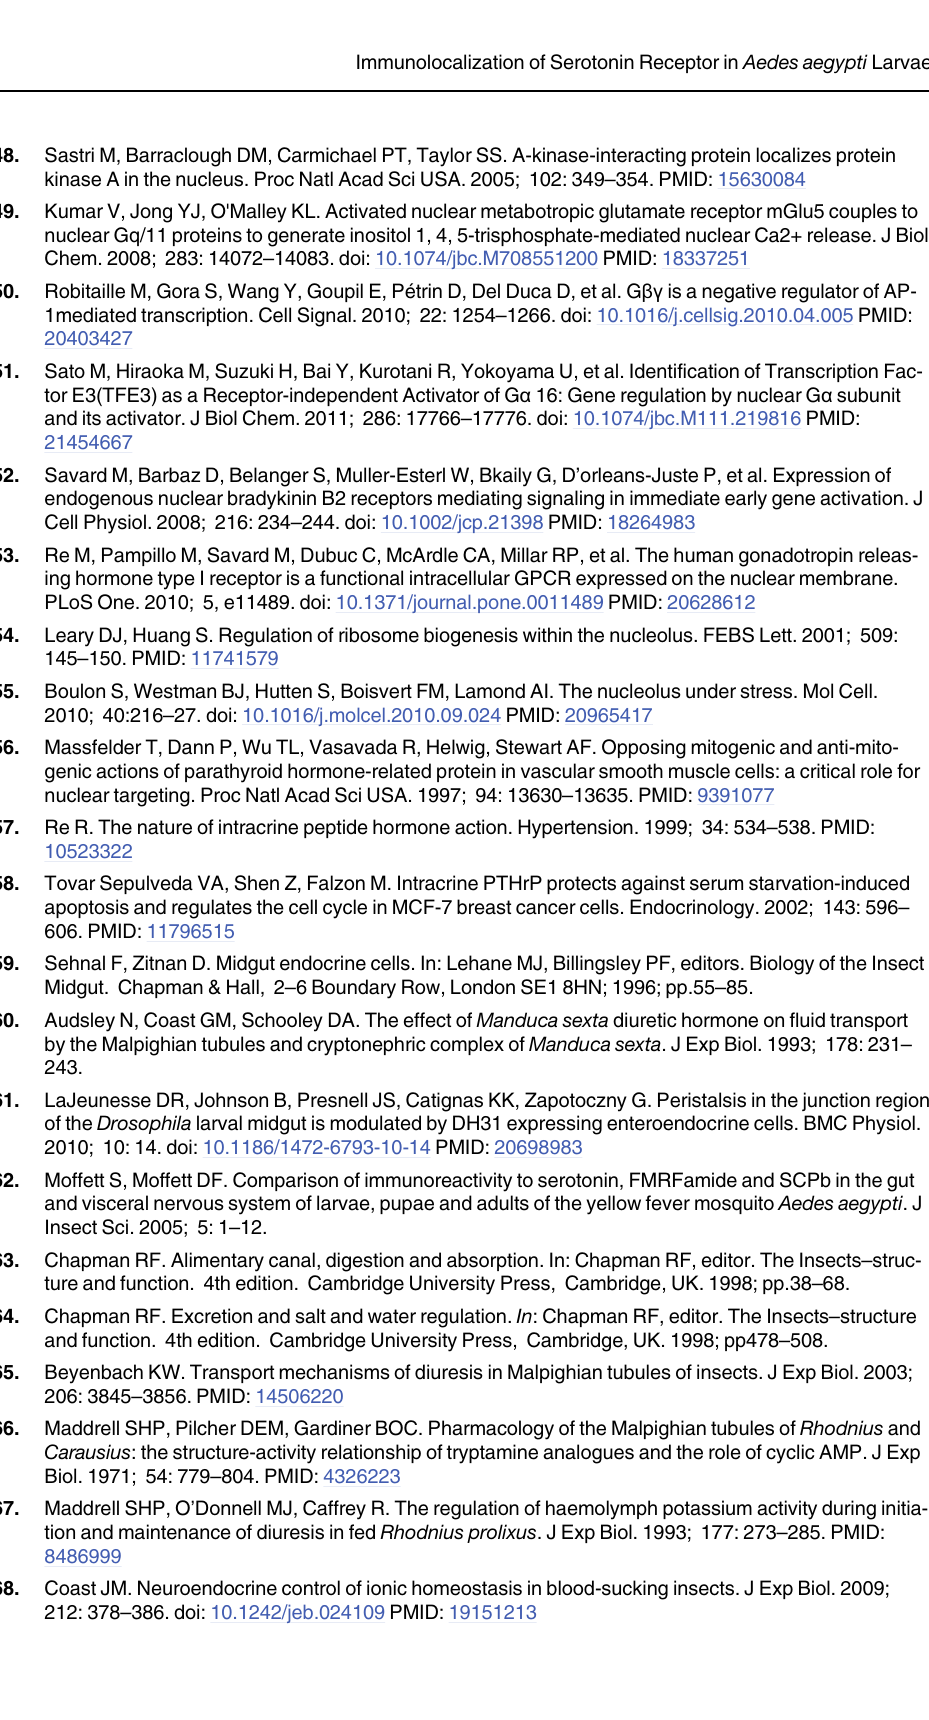
PLOS ONE | DOI:10.1371/journal.pone.0146587 January 25,